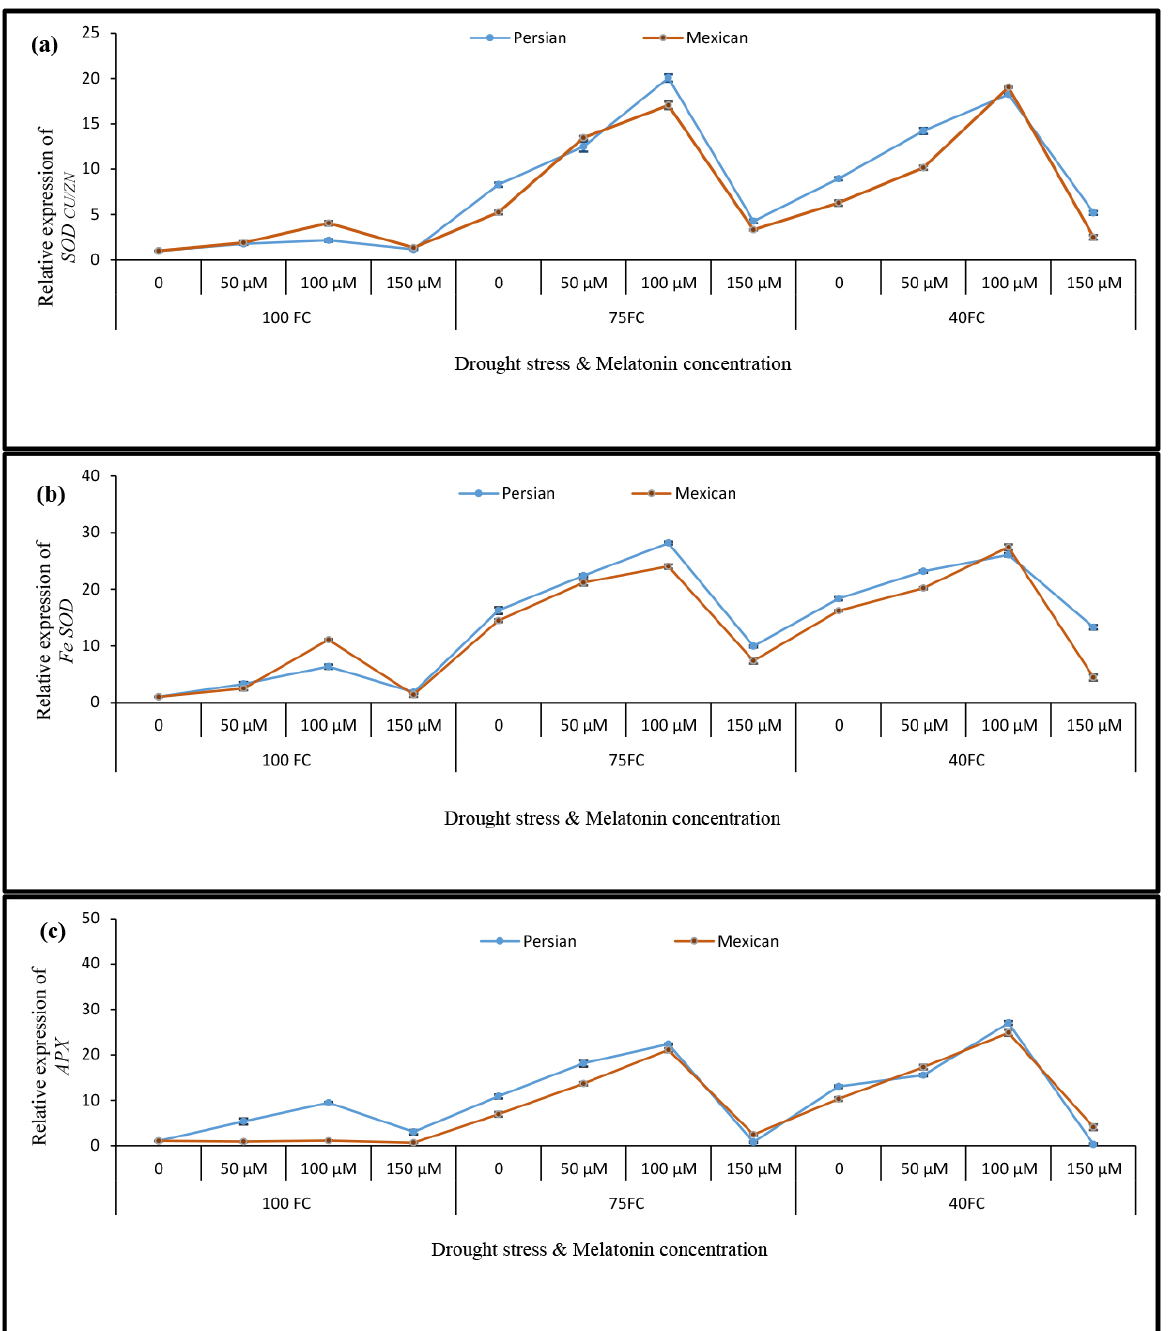
Figure 3. The effect of different concentrations of exogenous melatonin, Citrus species, and various levels of drought stress on the expression of ROS scavenging genes including ( a ) Cu/Zn superoxide dismutase, Cu/Zn SOD , ( b ) Fe superoxide dismutase, Fe SOD , and ( c ) cytosolic ascorbate peroxidase, cAPX . Data describe the means of three biological replicates with three technical replicates each. Error bars represent standard deviation (SD).